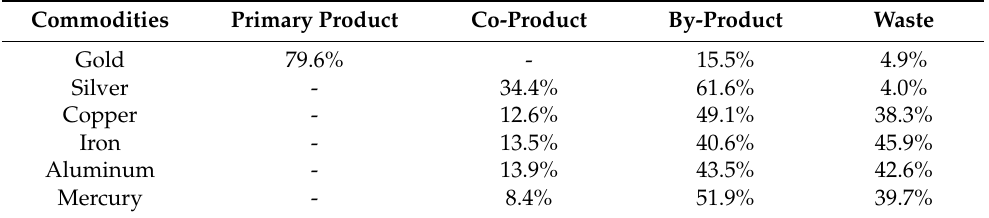
Table 9. Comparative analysis of production